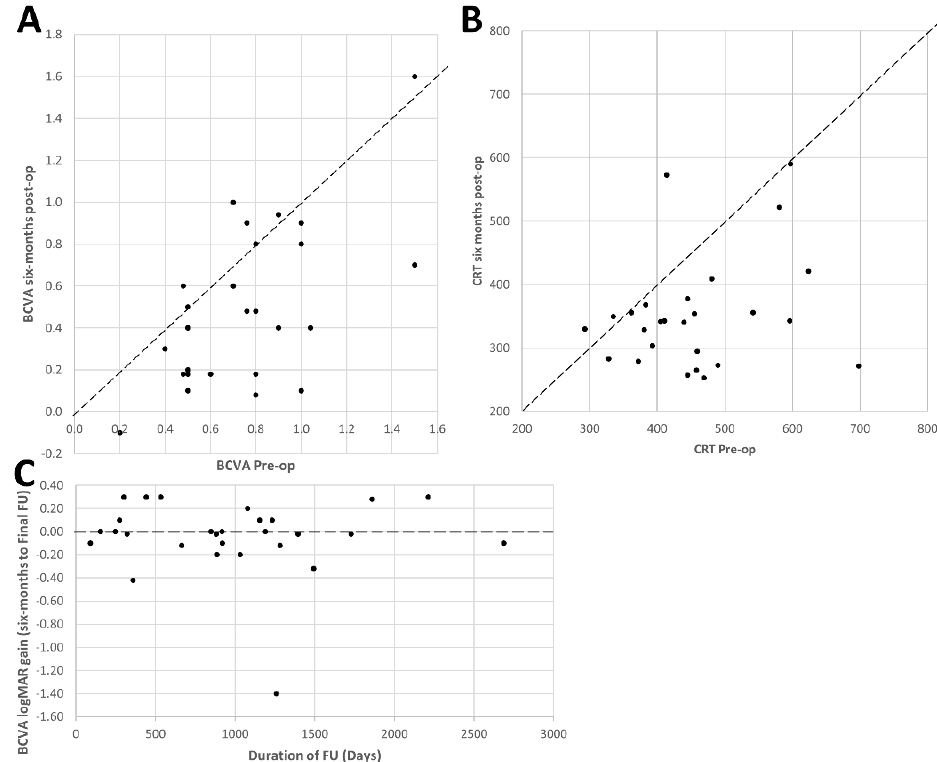
Figure 1. Central retinal thickness and visual acuity outcomes following ERM peel in uveitis patients. CRT: Central Retinal Thickness, ERM: Epiretinal Membrane, BCVA: Best Corrected Visual Acuity., FU: Follow ‐ up . Below the diagonal dashed black line represents improvement postoperatively for ( A ) visual acuity post ‐ operatively ( p < 0.001) and ( B ) CRT reduced significantly post ‐ operatively ( p < 0.001). ( C ) Above the dashed black line represents improvement in BCVA at final FU relative to six ‐ months. Even with prolonged FU, patients maintain their post ‐ operative logMAR gain with no difference at six ‐ month and final FU ( p = 0.726).